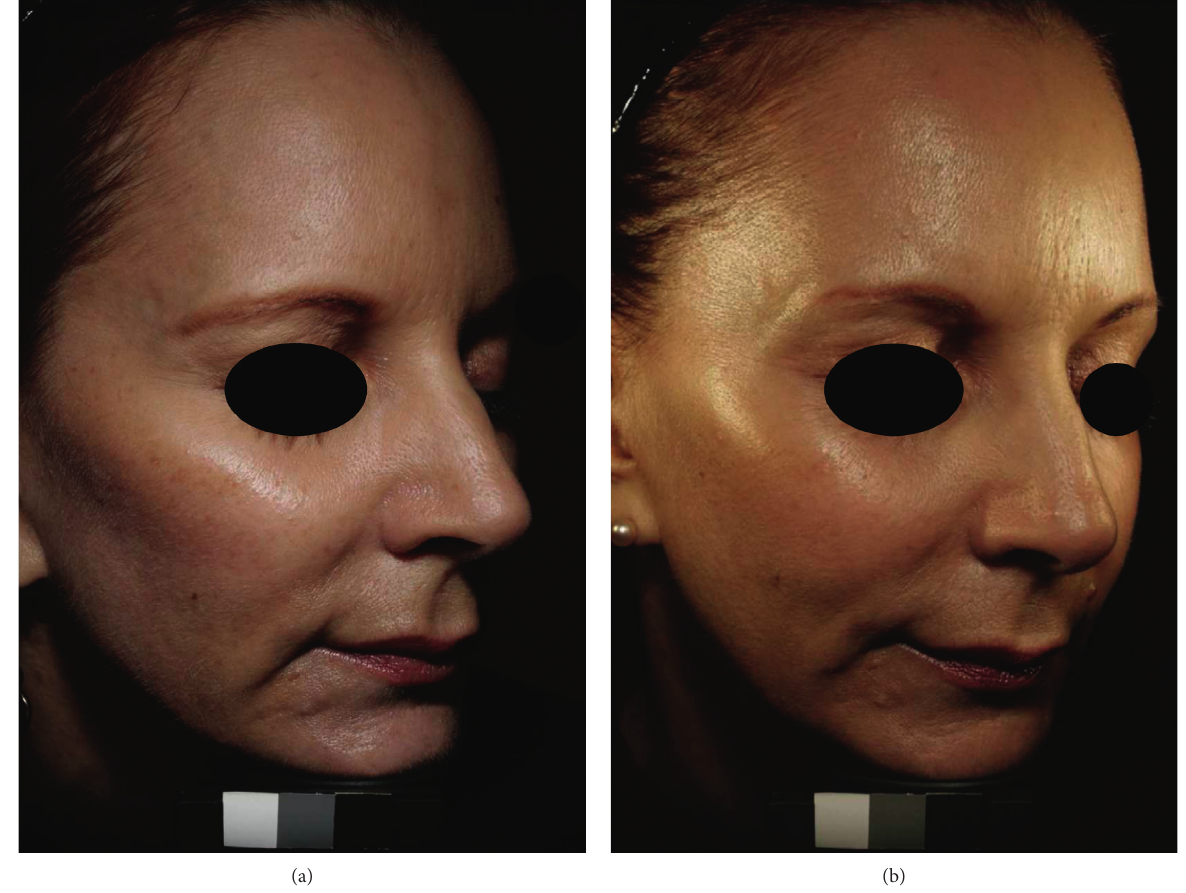
Figure 4: (a). Before Sculptra (Galderma, Fort Worth, TX, USA) injection. (b). 13 months after PLLA. Each of temporal, midface, and submalar areas received two vials of Sculptra